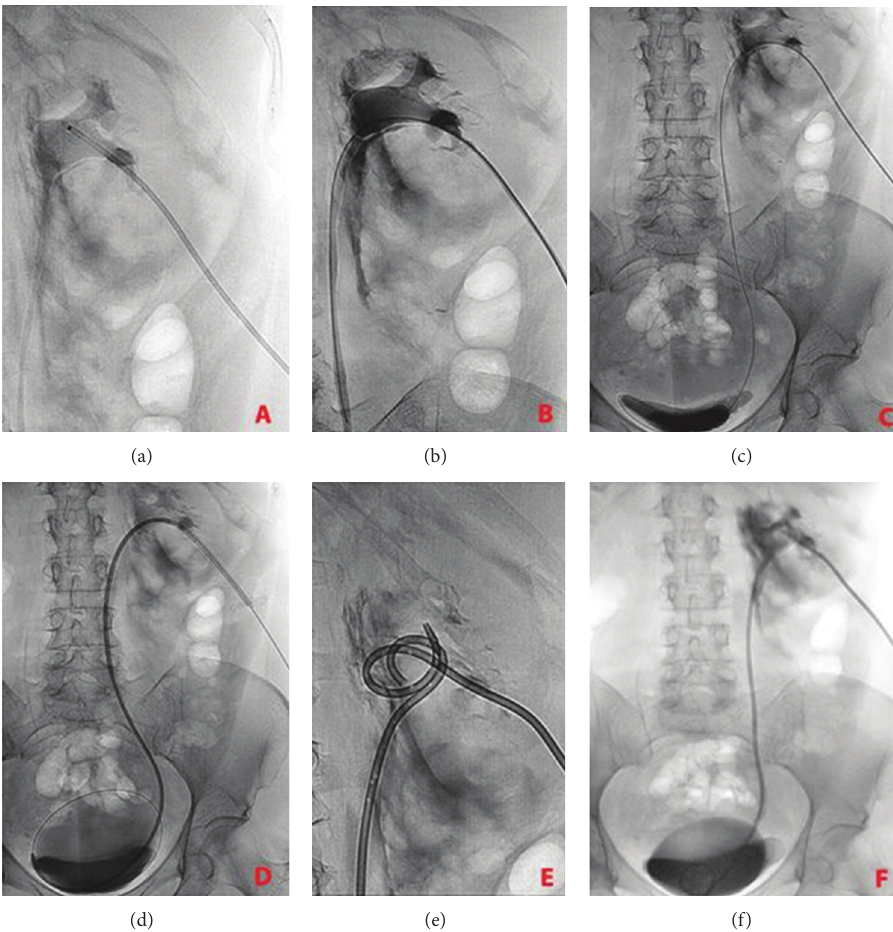
Figure 3: (a) Preprocedural urographic control; (b, c) advance of a stiff guidewire through the ureter in the bladder; (d) double-J stent placement; (e) diversionary protection nephrostomy positioning; and (f) postprocedural urographic